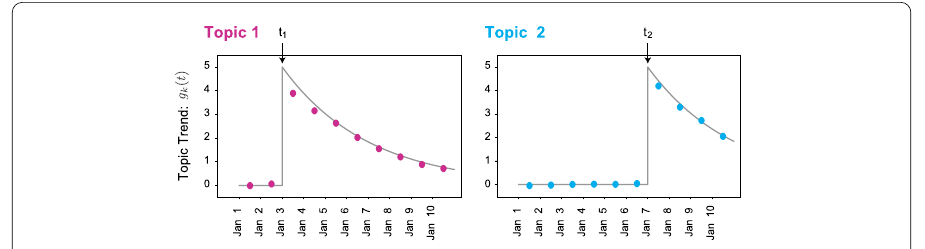
Figure 2 Estimating topic trends from synthetic data. Gray lines show the ground truth and the magenta and cyan circles show our estimate. Times of unobserved events are indicated by